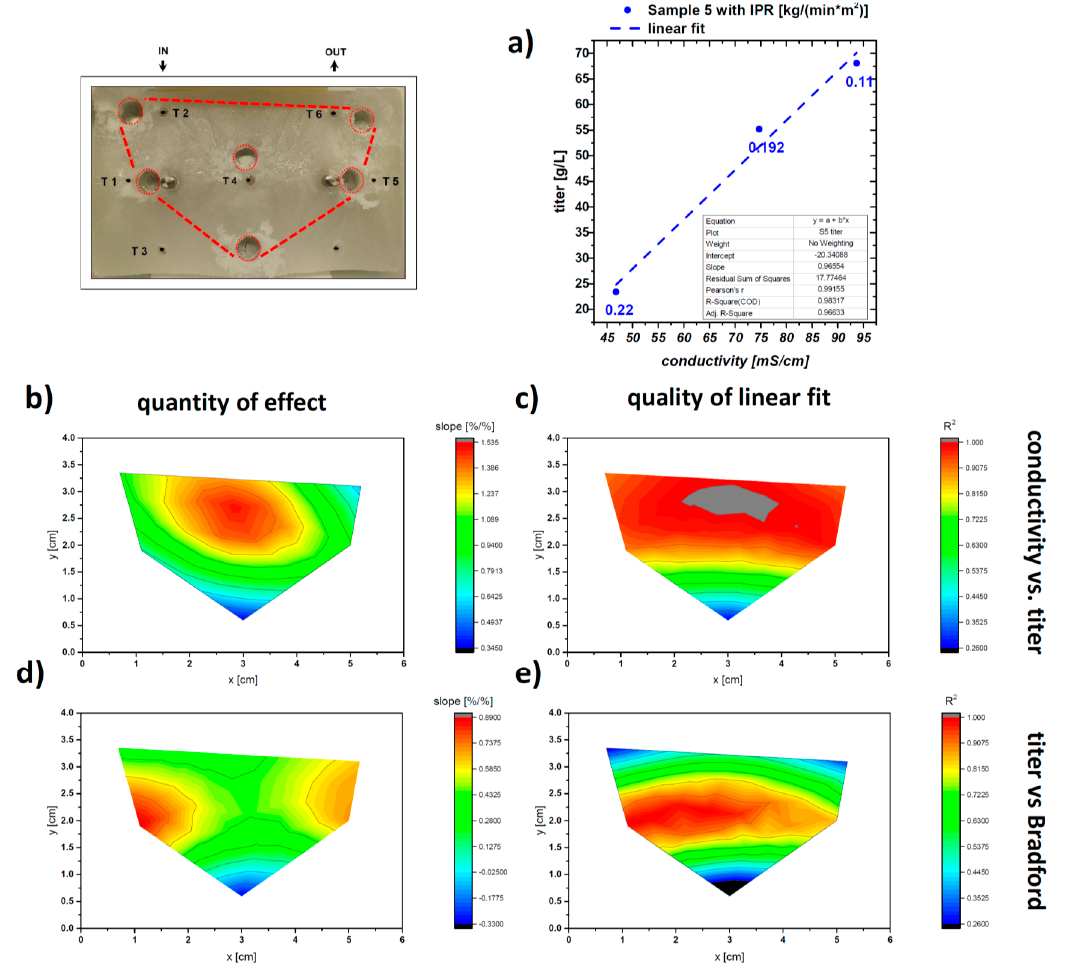
Figure 6. Analysis of the samples after freezing ( a ) exemplary linear fit of conductivity vs. titer; ( b ) Correlation of conductivity vs. titer, evaluated via linear regression based on the sampling points in Figure 2. A high correlation between conductivity and mAB titer is found with a R 2 ( c ) of 0.8 to 1 in the upper part of the sampling area: ( d ) Titer correlated to Bradford total protein measurement. In the regions of interests, a well-suited correlation can be found ( e ). HPLC measurements could be reproducibly replaced by photometric Bradford assays.